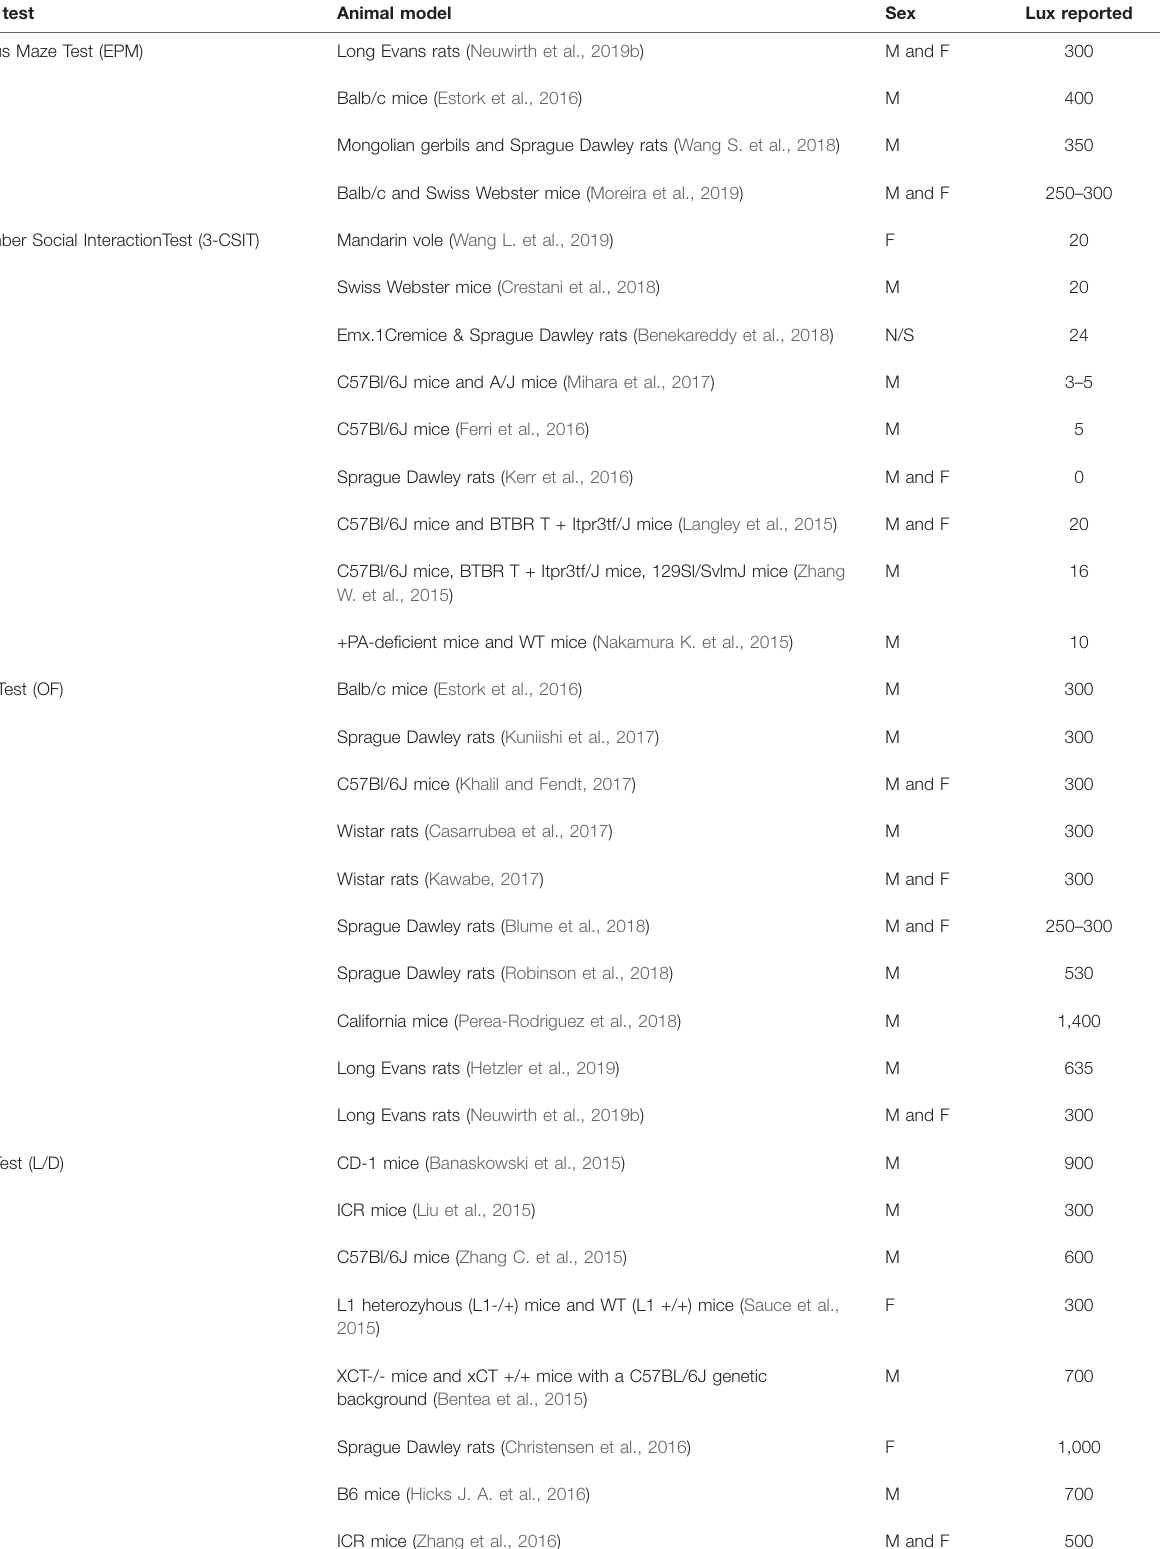
TABLE 1 | Variations in behavioral tests that met criteria for the Lux reported to motivate anxiety-like behaviors. Behavioral test Animal